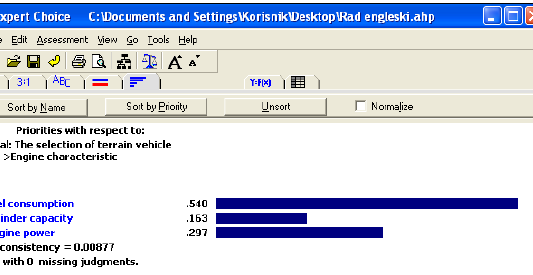
Figure 12. Protection